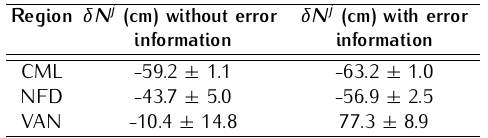
Table 4. LVD offset for Nov07 datum for CML, NFD, and VAN regions using goco03s (n max : 180) and error information for the el- lipsoidal, orthometric, and geoid heights.